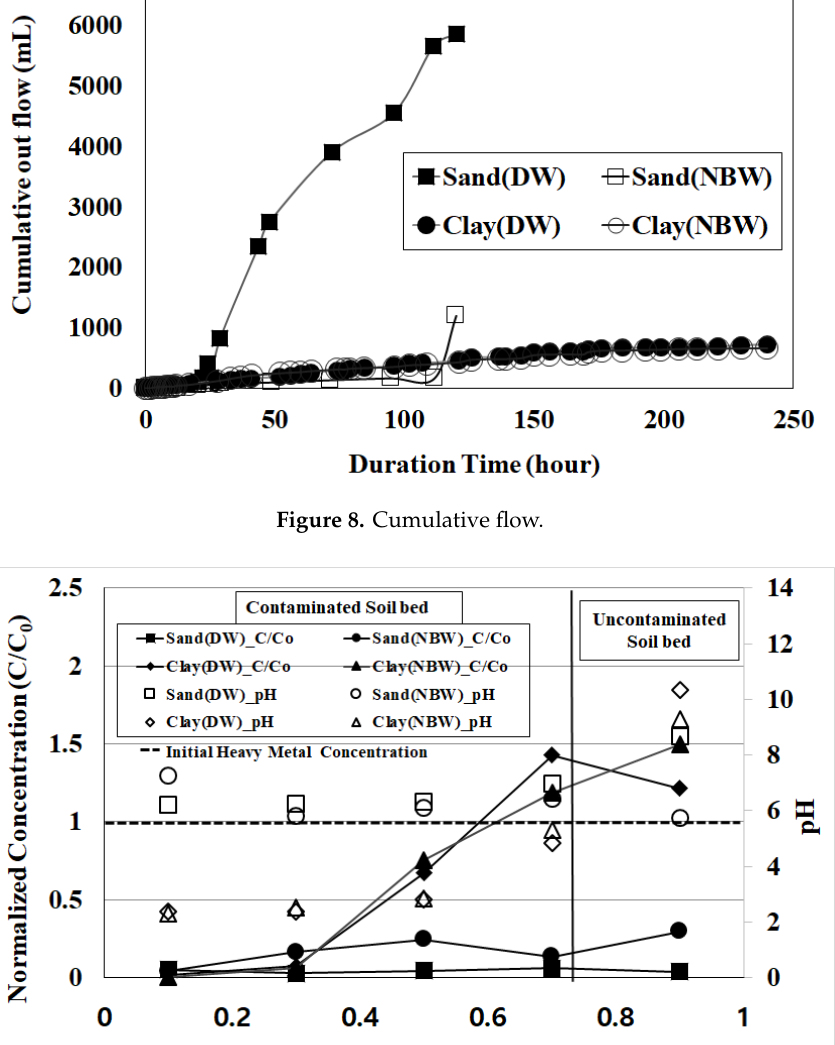
Figure 9. Final Copper Profile and pH at the end of Electrokinetic Test.